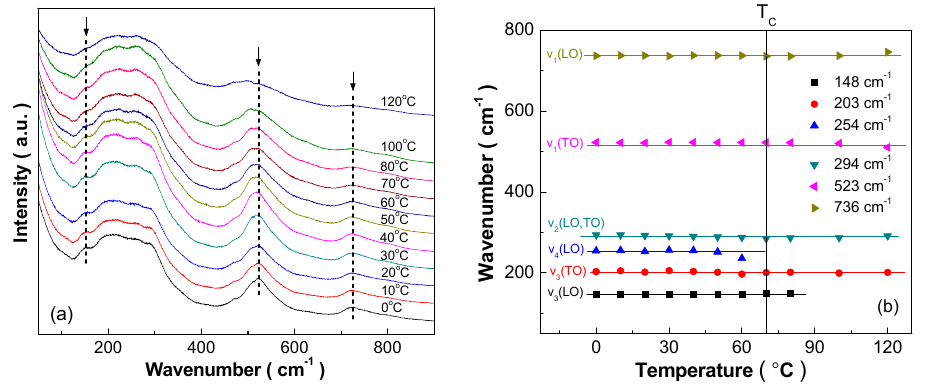
Figure 4. ( a ) Raman spectra of the BCZT-Li ceramics measured upon heating between 0 and 120 °C; ( b ) temperature dependence of wavenumber of different Raman vibration modes of the BCZT-Li ceramics.